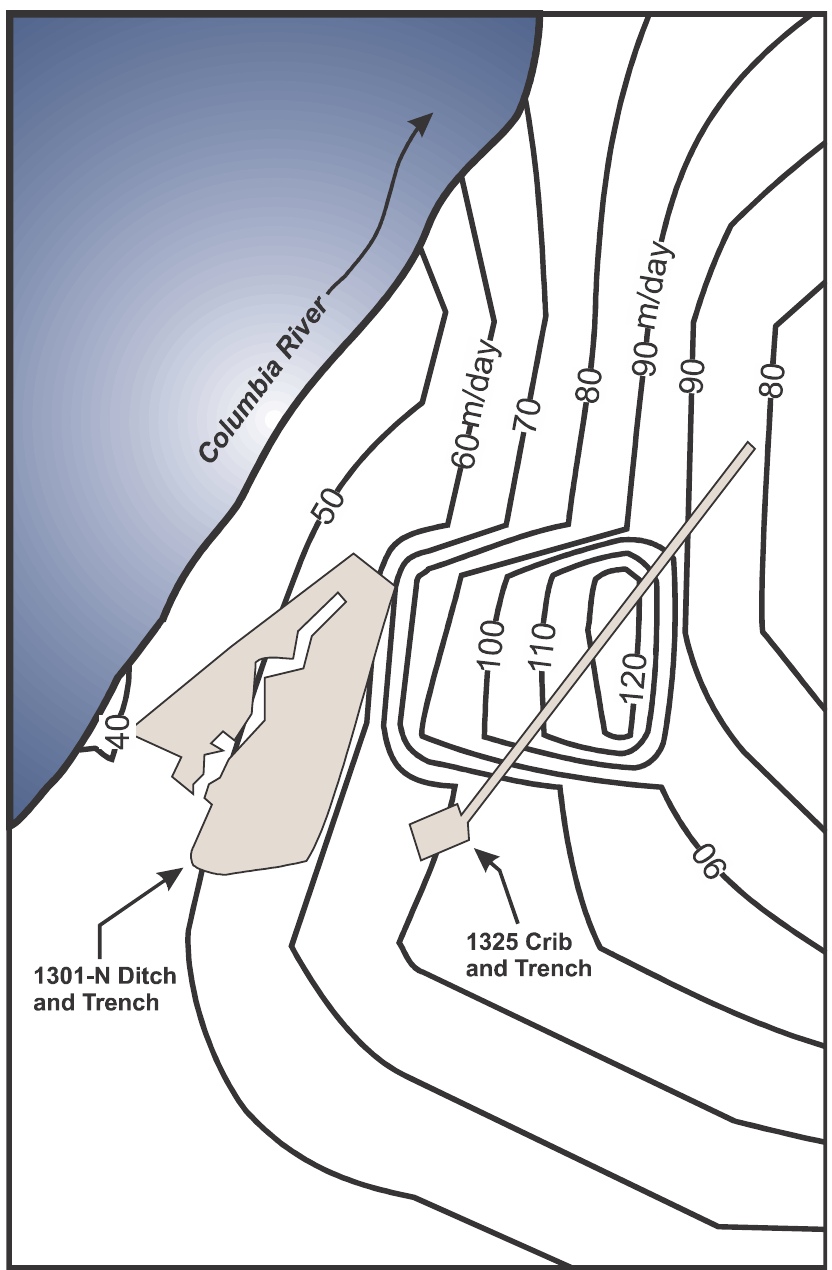
Figure 1. Saturated hydraulic conductivity distribution around the 1325 Crib area. The hydraulic conductivity distribution was derived using samples along with calibrated heterogeneous models.